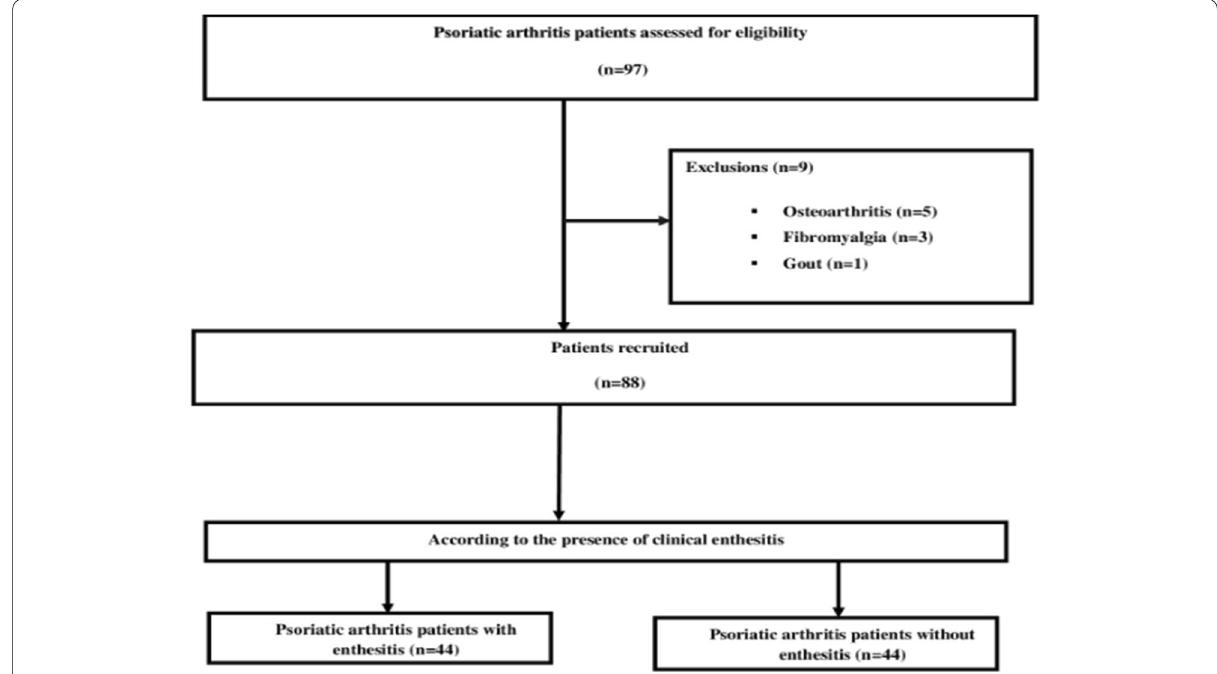
Fig. 1 Flowchart of the